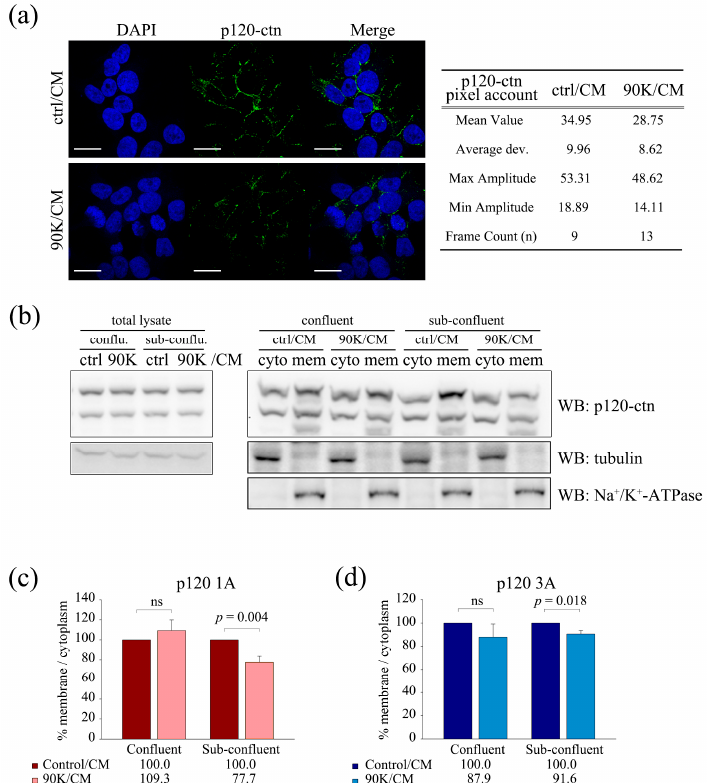
Figure 6. 90K affects the cellular localization of p120-catenin. ( a ) 90K conditioned media (90K/CM) treatment decreased the membrane localization of p120-catenin. 293T cells were treated with either ctrl/CM or 90K/CM for 16 h and immunostained using p120-catenin antibody. Representative images are shown in the left panel. Pixel counts for p120-catenin fluorescence are shown in the right panel. Scale bar, 20 µ m. ( b ) 90K/CM treatment decreased the membranous fraction of p120-catenin. 239T cells were treated with either ctrl/CM or 90K/CM for 16 h, followed by subcellular fractionation of proteins into either cytoplasmic or membrane fractions. Lysates were then subjected to western blot analysis using an anti-p120-catenin antibody; ( c , d ) Quantitative analysis of p120-catenin fractionation. The results of at least seven independent experiments were analyzed to determine statistical significance. ns, no‘significant difference was found between the indicated